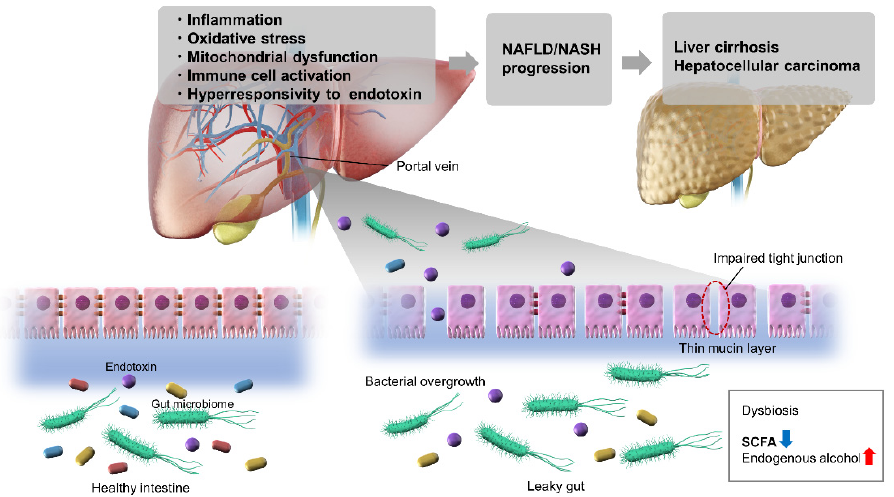
Figure 1. Schematic diagram of the gut–liver axis in non-alcoholic fatty liver disease/non-alcohol fatty liver disease. NAFLD, non-alcoholic fatty liver disease; NASH, non-alcoholic steatohepatitis; SCFA, short chain fatty acids.